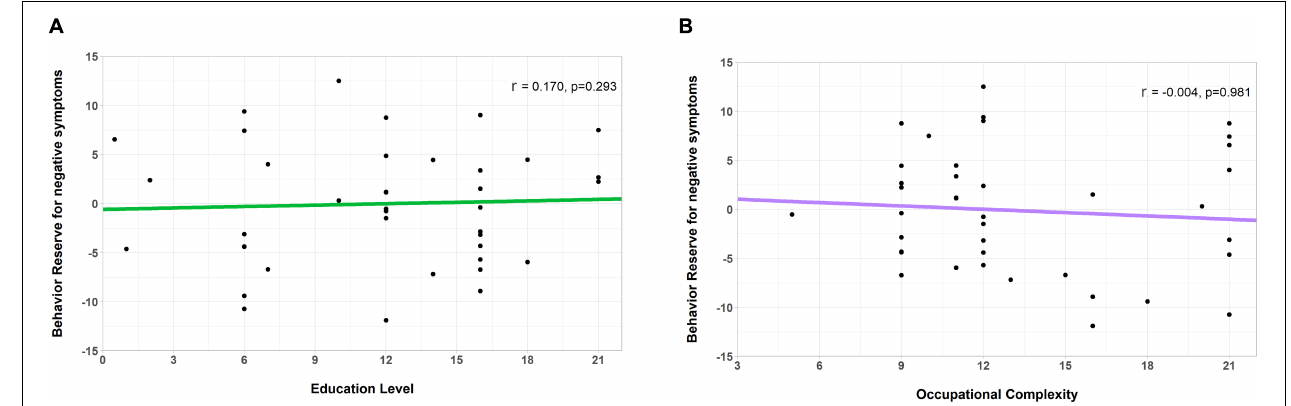
FIGURE 4 | Correlation of the behavioral reserve marker for negative symptoms (an nBR marker) with the education level and occupation complexity (markers for other reserves). Scatterplots showing the relationship between the nBR marker, education level, and occupational complexity. The nBR marker was not significantly correlated with (A) the education level ( r = 0.170, p = 0.293) or (B) the occupational complexity ( r = –0.004, p = 0.981). nBR, behavioral reserve for negative symptoms.